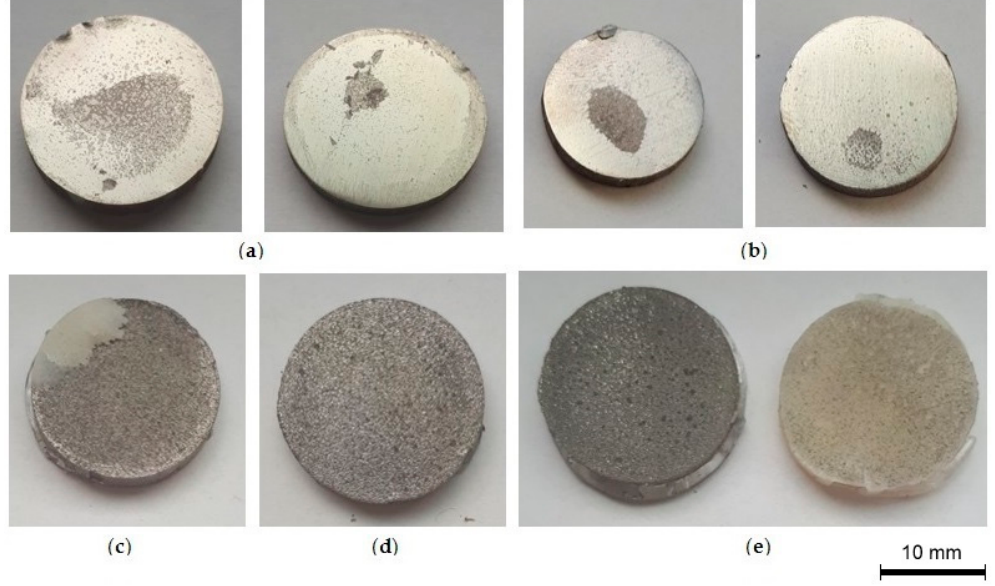
Figure 6. Images of selected specimens after detachment of bone cement coatings by pull-off-test ( a ) Solid bar; ( b ) Ground SLM; ( c ) Untreated SLM; ( d ) Etched SLM; and, ( e ) Sandblasted SLM (the presented pictures are representative for five experiments).